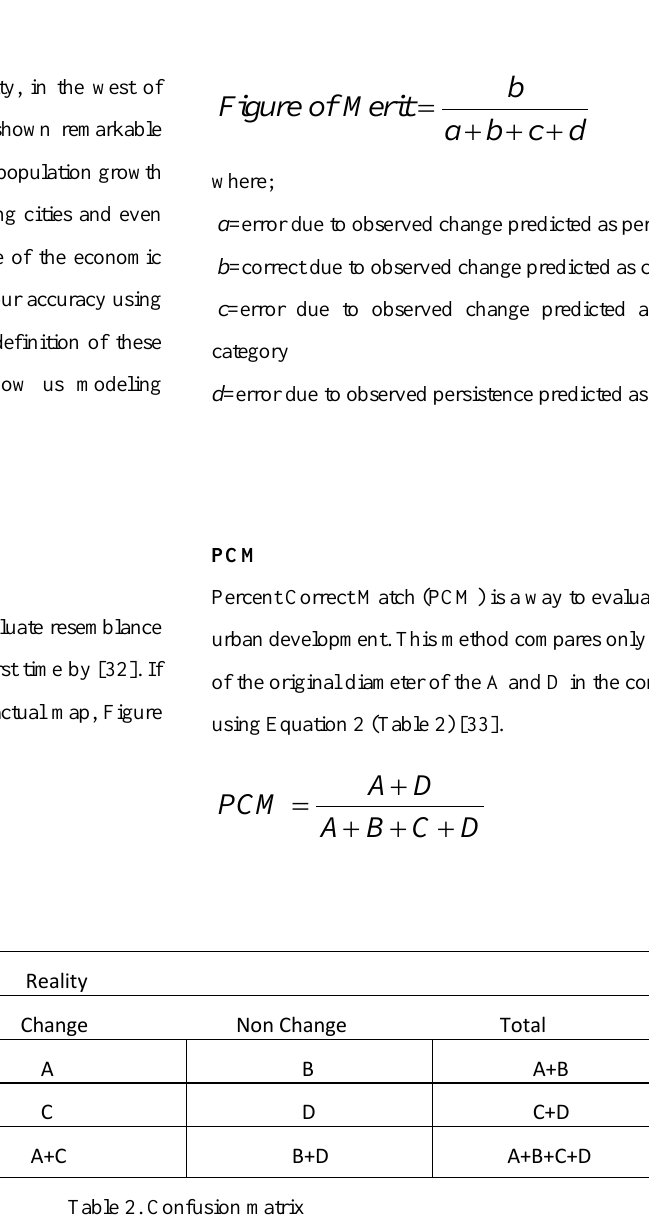
data) the urban pattern (year 2006) based on current urban growth trends (Fig.